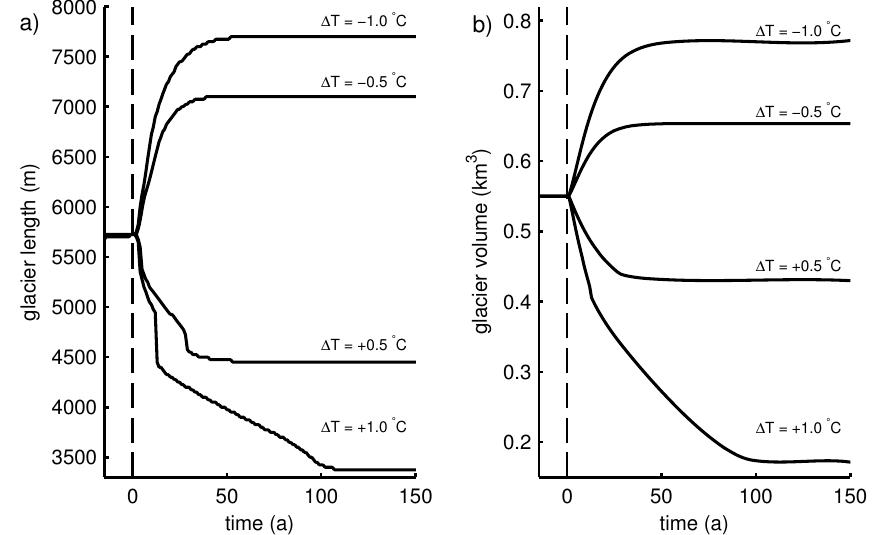
Fig. 8. (a) Length and (b) volumes changes of Glaciar Fr´ıas after perturbation of the 1980–2009 climate with 1T =+1.0, +0.5, − 0.5 and − 1.0 ◦ C at t =0. It shows the response of Glaciar Fr´ıas to perturbations in climate. For 1T =+1 ◦ C, the glacier retreats over the overdeepening in the bed, which causes a drastic decrease in both volume and length.